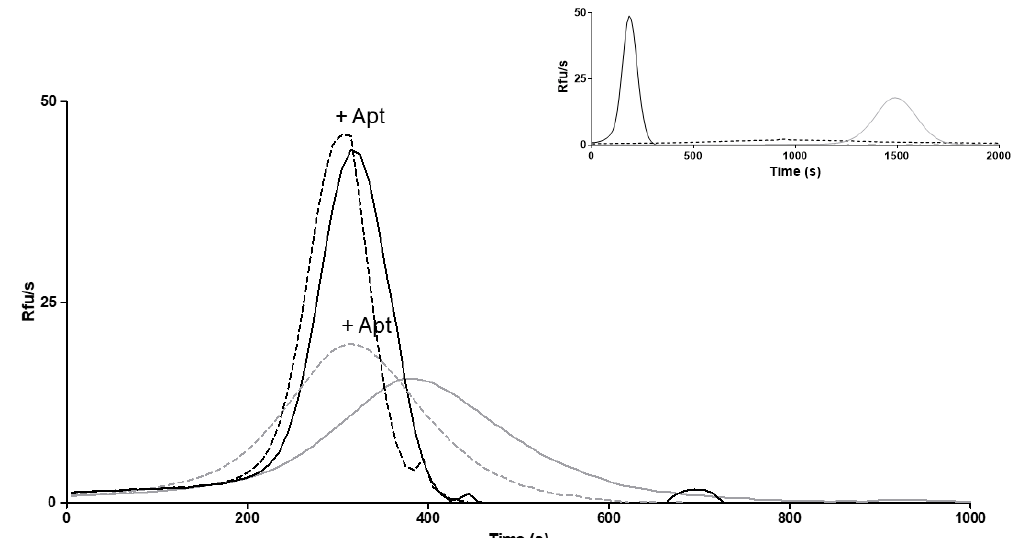
Figure 6. FXa generation in medium from cells treated with 4-PBA. FXa generation activity in FVII-deficient plasma added with medium from 4-PBA treated cells (continuous black line) and untreated (continuous gray line) cells, or in the presence of anti-TFPI aptamer (+Apt) in medium from 4-PBA treated (dotted black line) and untreated (dotted gray line) cells. RFU/s, relative fluorescence units/second. Inset: curves obtained with diluted (0.1%) medium containing rFVIIwt (black line), vector alone (dotted line) or FVII-deficient plasma alone (gray line).